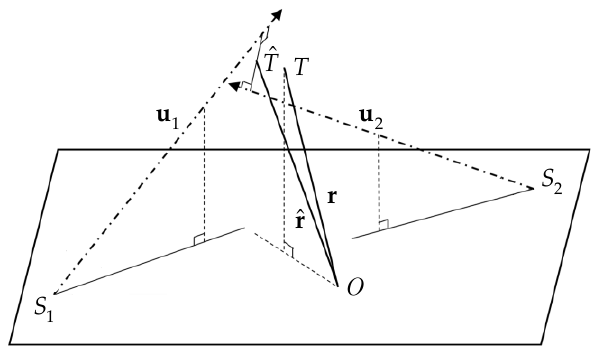
Figure 4. Diagram of asynchronous cross-location by two lines of sight.